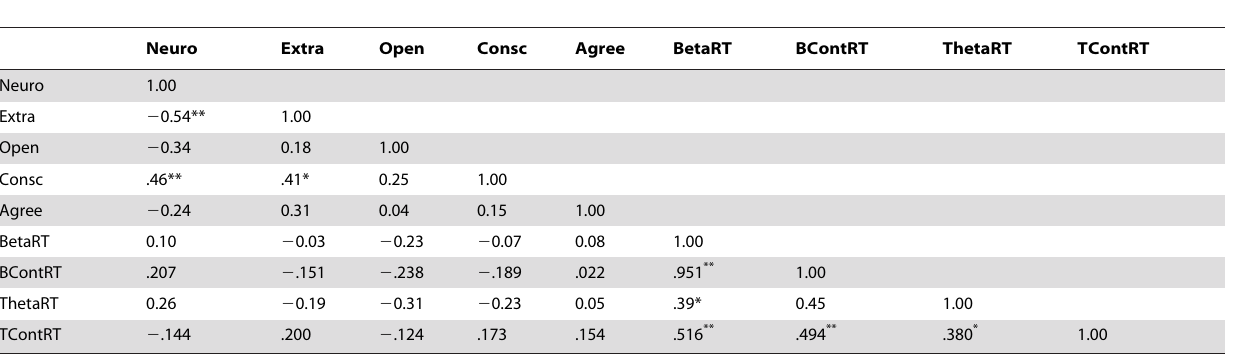
Table 3. Correlation Table of NEO Personality Traits and Vigilance Task Reaction Time during Beta, Theta and Control Conditions.